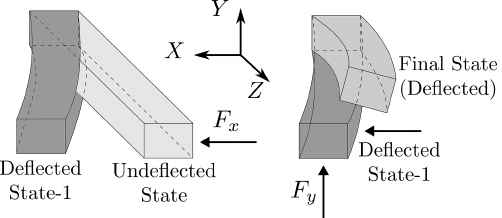
Figure 2. Illustration of beam deflections in lateral directions and the resulting torsion motion due to the bending–torsion coupling at the deflected state. The lateral ( x , y ) and axial ( z ) directions are given in beam root